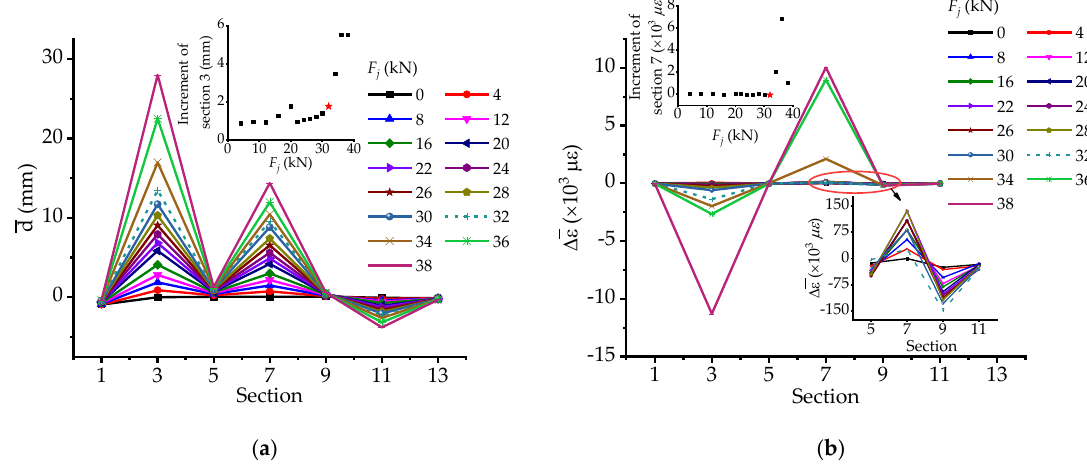
Figure 9. The changing features of generalized bending moment stressing state modes: ( a ) Generalized in-plane bending moment stressing state mode; and ( b ) generalized out-plane bending moment stressing state mode.